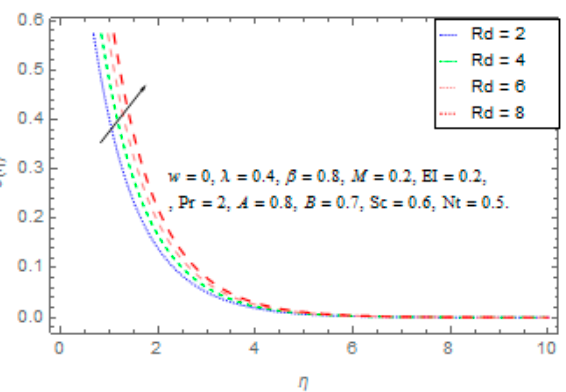
Figure 7. Influence of Rd on temperature profile.